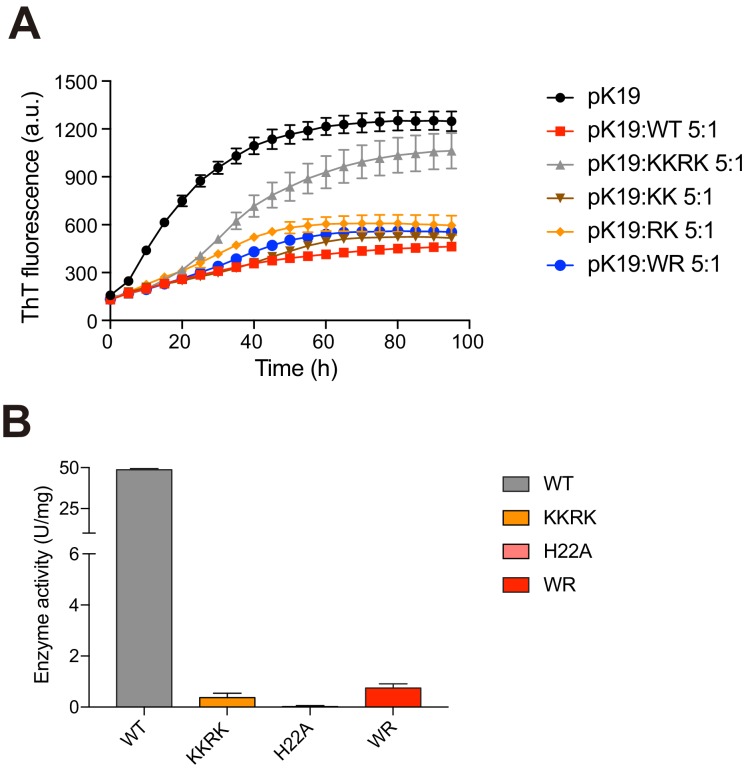
Activities of mN3 variants.(A) ThT fluorescence assays (top) shows the influences of mN3 mutations on the inhibition of pK19 (100 μM) amyloid aggregation. The molar ratios of pK19 to mN3 variants are indicated. The data shown correspond to mean ± s.d., with n = 5. (B) The enzymatic activities of mN3 variants measured with the NMN concentration of 625 µm are shown below. The data shown correspond to mean ± s.d., with n = 3.